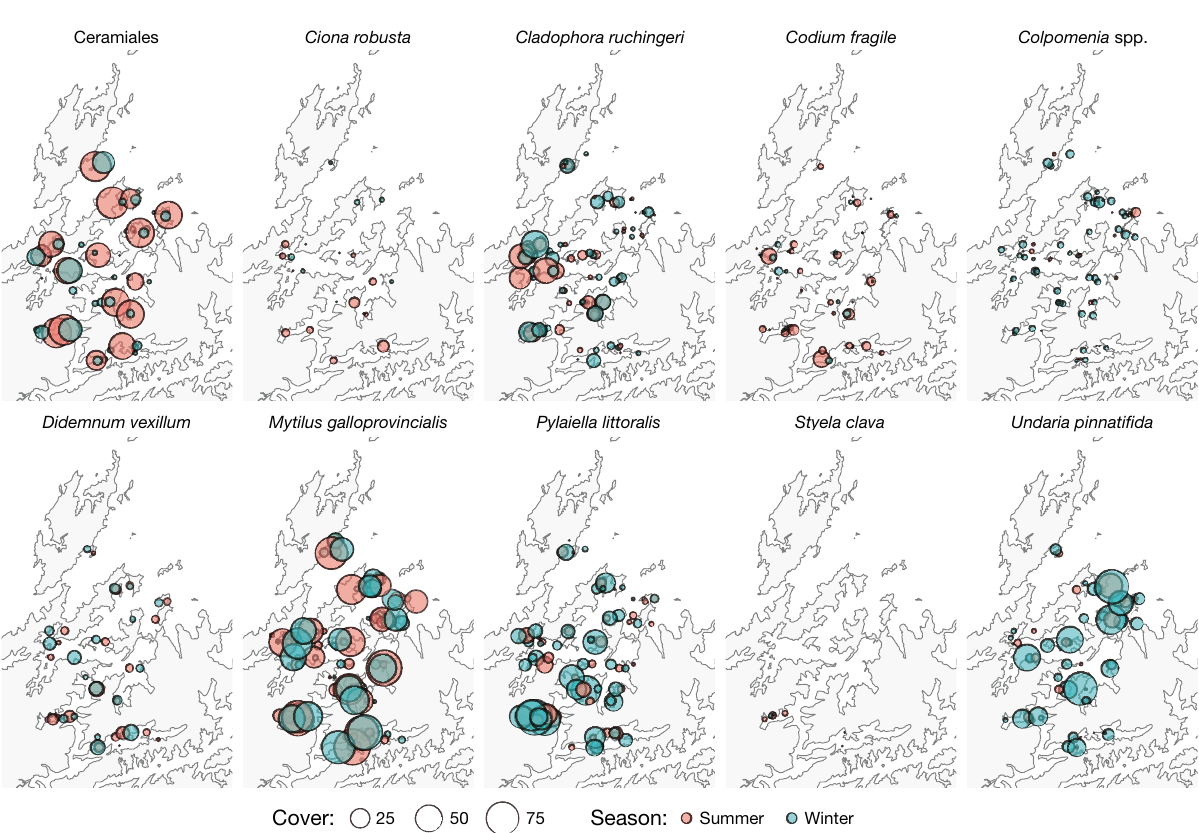
Fig. 3. Regional distribution of percent cover of the 10 focal taxa surveyed in Pelorus Sound during summer (February 2018) and winter (September 2018)